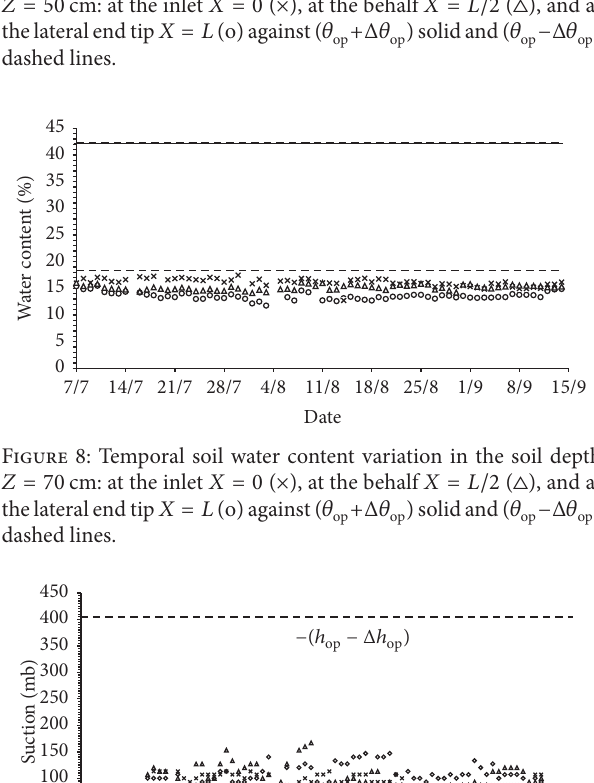
+Δ𝜃 −Δ𝜃 ) solid and ( 𝜃 ) op op op op